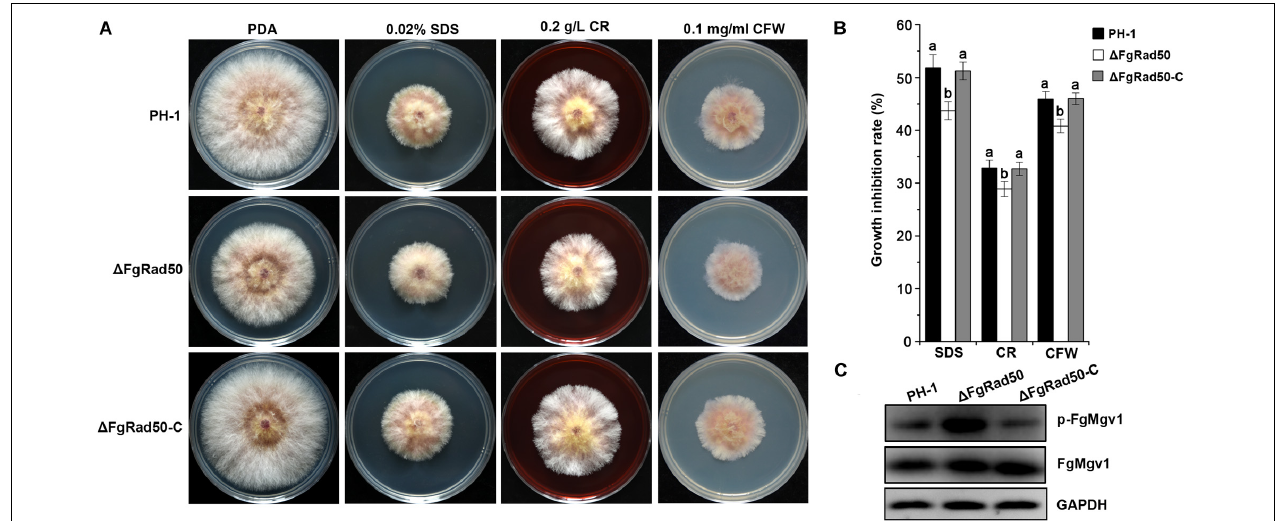
FIGURE 4 | Role of FgRad50 in sensitivity to cell wall-damaging agents. (A) PH-1, (cid:49) FgRad50 and (cid:49) FgRad50-C were grown on PDA and PDA supplemented with 0.02% sodium dodecylsulphate (SDS), 0.2 g/L Congo Red (CR) or 0.1 mg/mL Calcofluor White (CFW). All plates were incubated at 25 ◦ C for 3 days. (B) Mycelial growth inhibition rates of PH-1 and mutants on various media. Bars denote standard errors from three experiments. Values above bars followed by the same letter indicate no significant difference at P = 0.05. (C) Comparison of phosphorylation levels of FgMgv1 in PH-1, (cid:49) FgRad50 and (cid:49) FgRad50-C. Phosphorylated FgMgv1 (p-FgMgv1) and FgMgv1 proteins were detected using phospho-p44/42 MAP kinase antibody and the Mpk1 kinase antibody, respectively. The monoclonal anti-GAPDH antibody was used as a